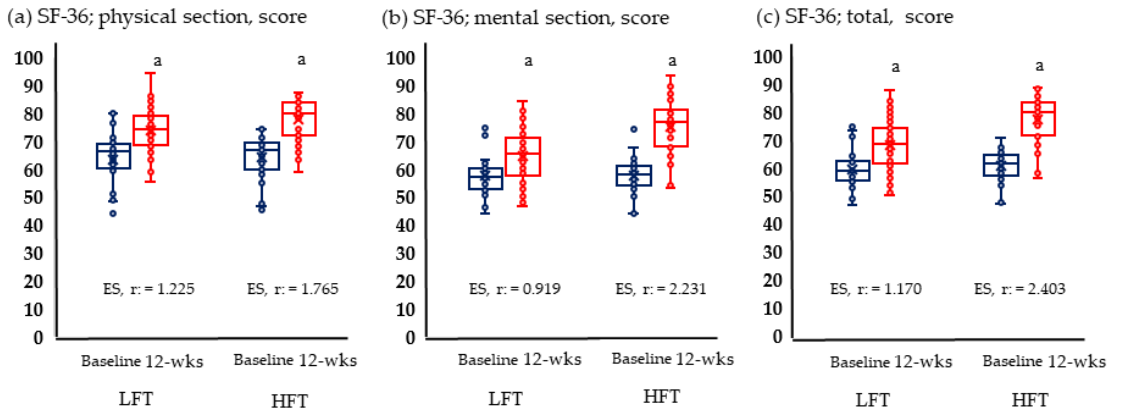
Figure 3. Change in quality of life; ( a ) Change of physical section; ( b ) change of mental section; ( c ) change of total score anaerobic in LFT and HFT groups according to 12 weeks intervention. p < 0.05; a, Baseline vs. 12 wks; LFT, low-frequency training; HFT, high-frequency training; ES, effect size. Blue boxplots are baselines corresponding to pre-intervention, and red boxplots are 12-wks post-interventions.